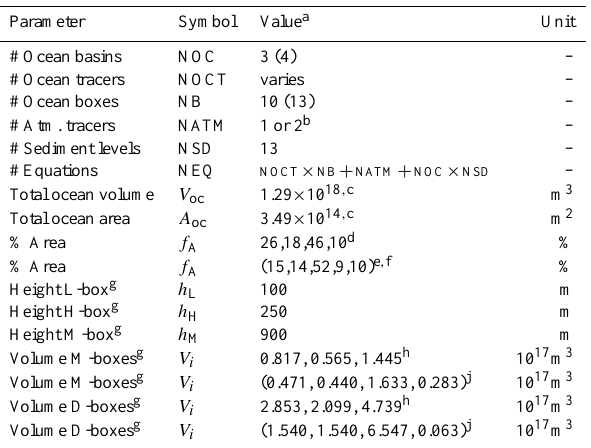
Table 1. Model-architecture and ocean geometry